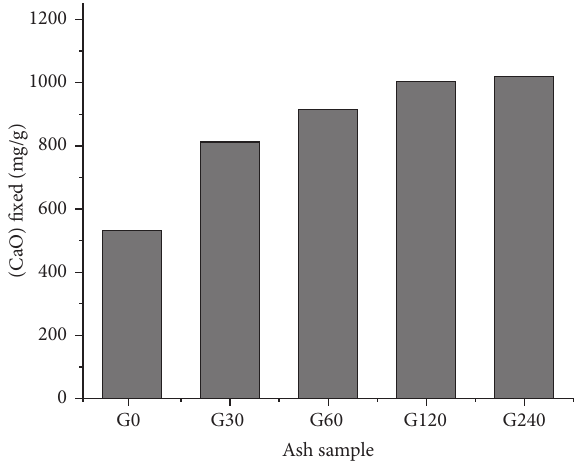
Figure 16: Chapelle test at different grinding times. Table 5: Mix proportion and compressive strength of corn stalk ash at different grinding times (w/ c ratio � 0.4).